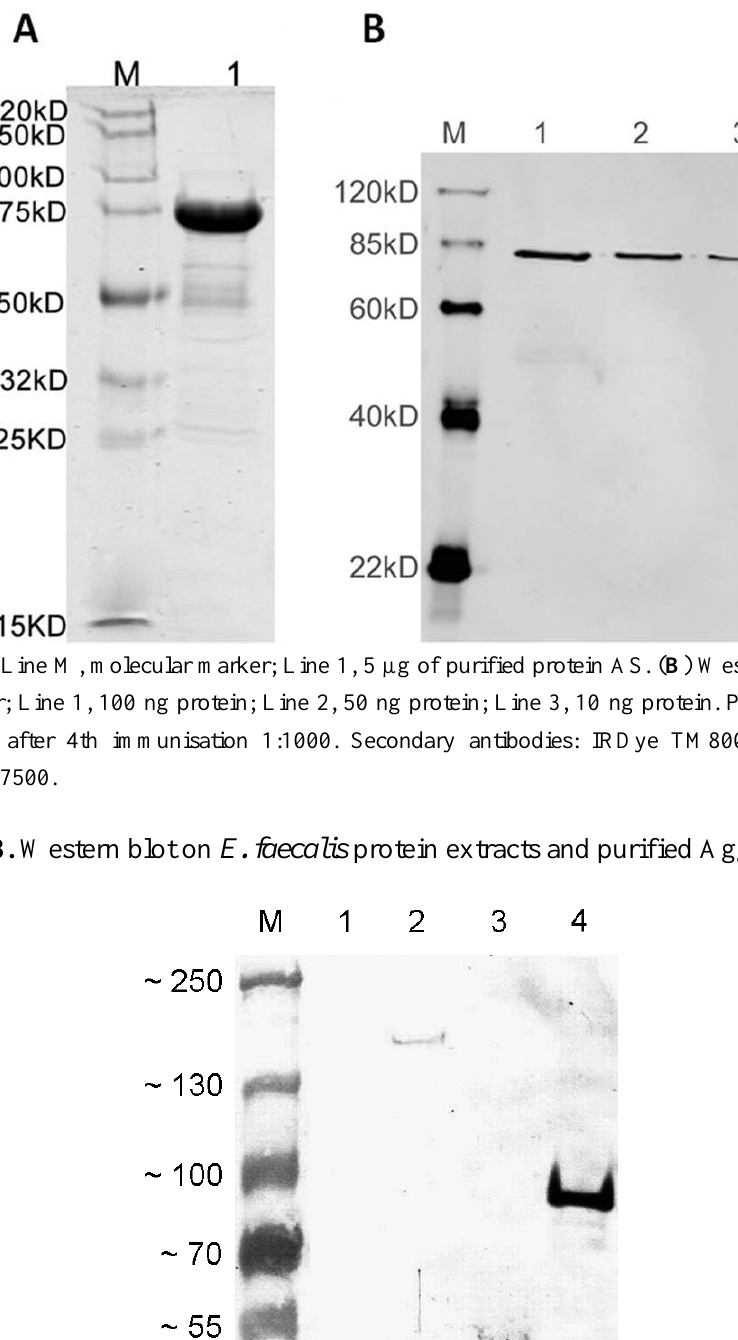
Figure 2. SDS-PAGE and western blot of the purified protein AS.